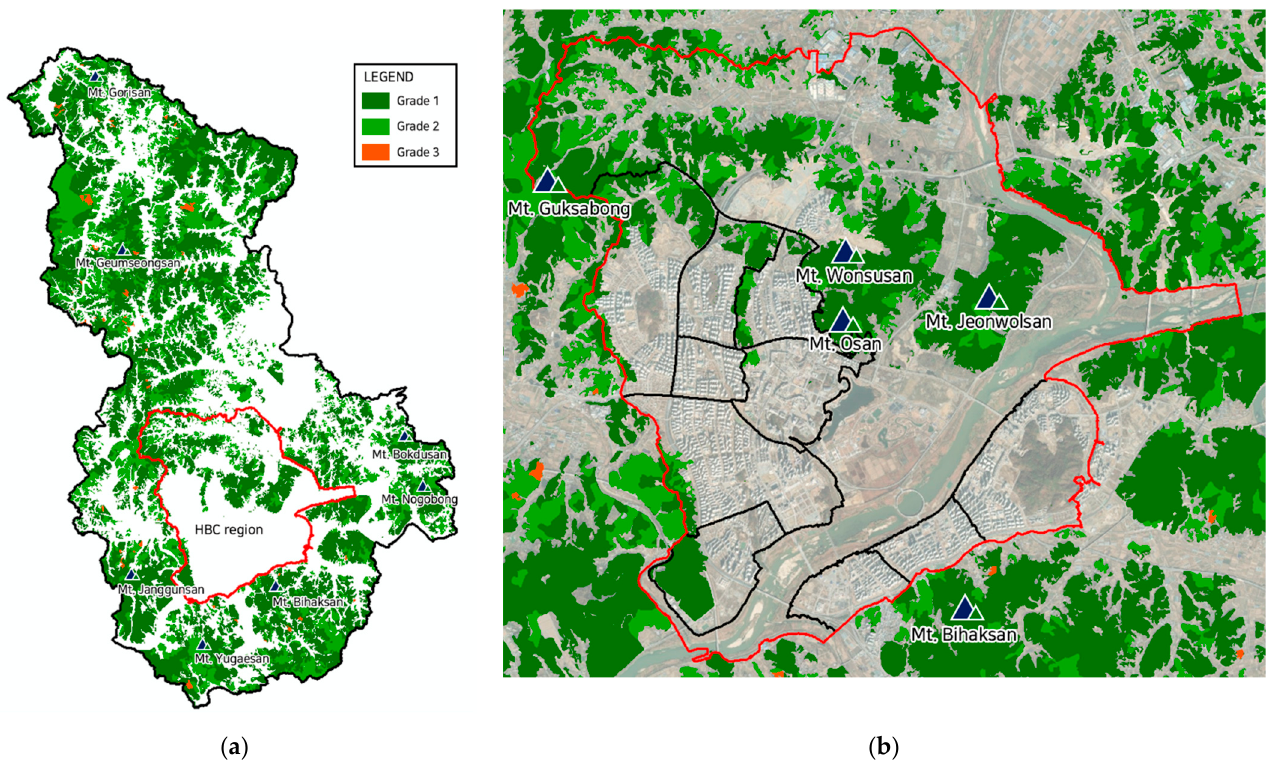
Figure 4. Distribution of wind-generating forest (WGF): ( a ) Sejong; ( b ) HBC region. Wind-spreading forests (WSFs) in Sejong were mainly parks in the urbanization area and green spaces, mostly concentrated in the center of the HBC region. As the HBC region is a recently built planned city, WSFs were evenly distributed.